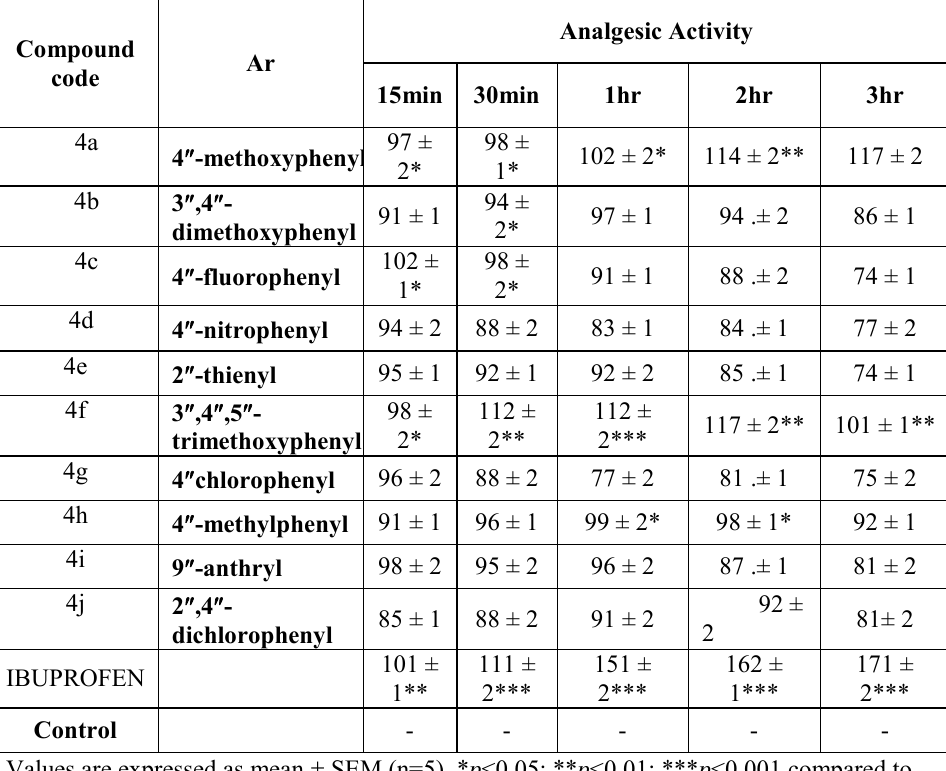
Table 3. Analgesic activity of 2-pyrazolines 4 (a-j).